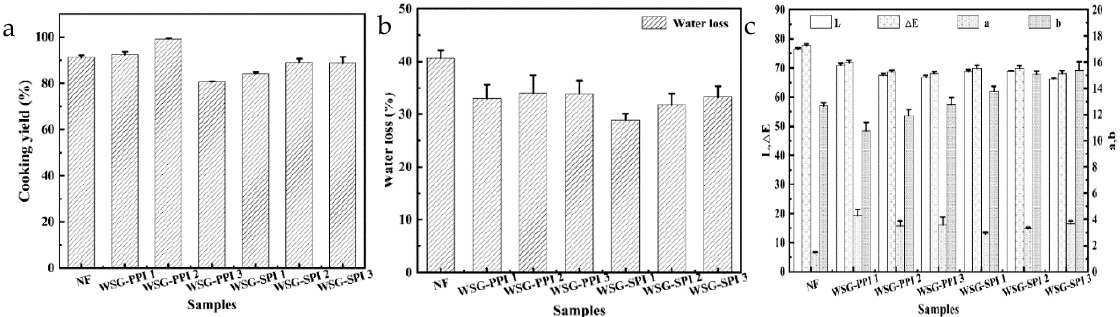
Figure 7. Cooking yield ( a ), water loss ( b ) and color ( c ) of low-fat sausages.